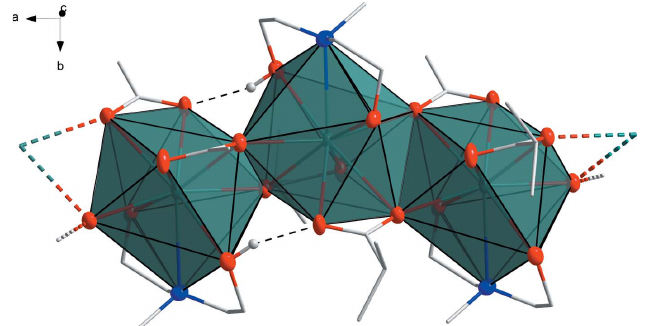
Figure 3 Representation of a segment of the polymeric structure of [Sr(ib) 2 (H 2 mda)] n ( I ) along the crystallographic c axis. Color code: Sr teal, C gray, N blue, O red, bridging O spheres red and H atoms white. Hydrogen bonds are shown as dashed black lines. Disordered fragments are omitted for clarity.